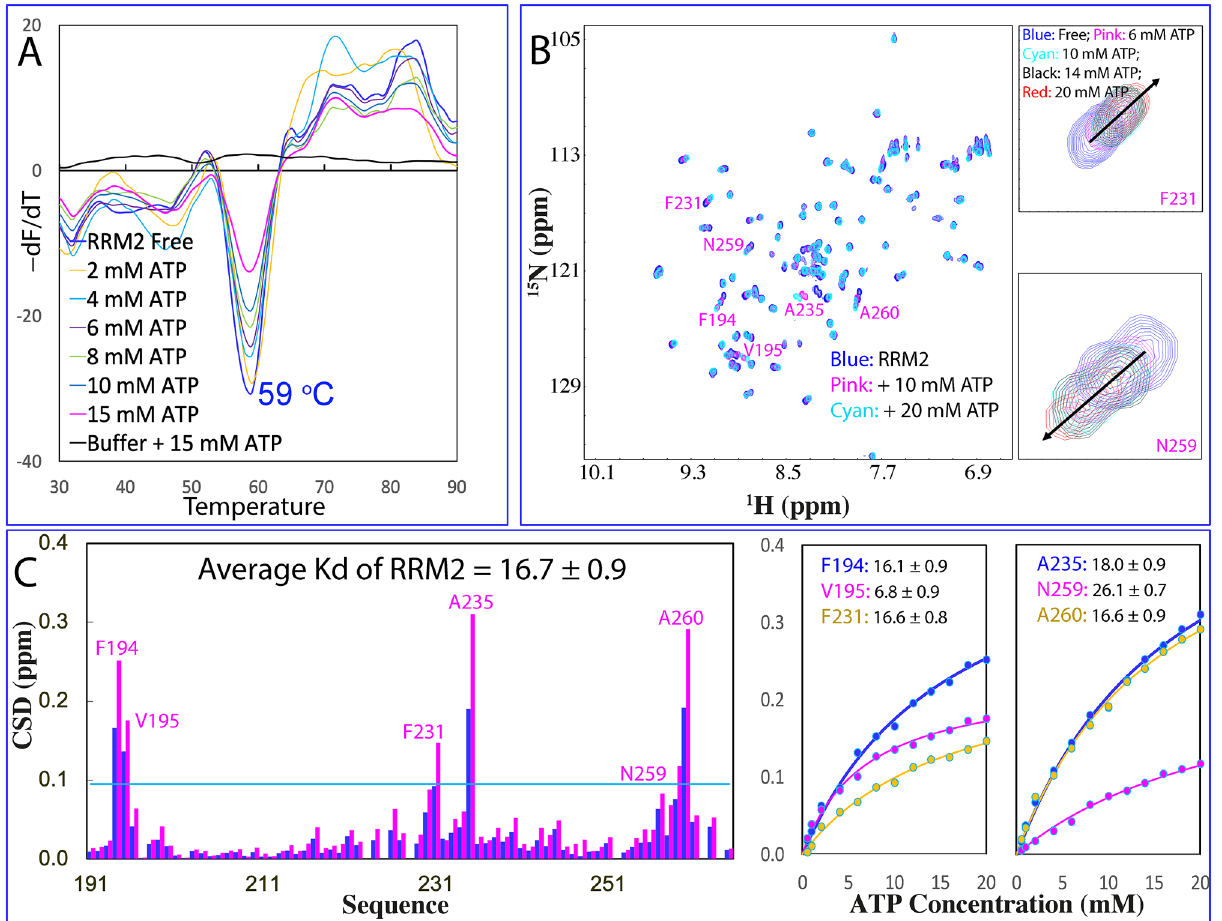
Figure 2. Thermal stability and ATP binding of the isolated TDP-43 RRM2. ( A ) DSF melting curves of thermal unfolding of the isolated RRM2 domain in the presence of ATP at different concentrations. ( B ) 1 H- 15 N NMR HSQC spectra of the 15 N-labeled RRM2 domain at 50 μM (blue) in 10 mM sodium phosphate buffer (pH 6.8) containing 150 mM NaCl and 10 mM DTT in the absence (blue), and in the presence of ATP at 10 (pink) and 20 (cyan) mM. Traces of two representative HSQC peaks, which have significant shifts but are not severely overlapped with other peaks. For clarity, only peaks at five ATP concentrations are shown: in the free state (blue); in the presence of ATP at 6 mM (pink); 10 mM (cyan); 14 mM (black); and 20 mM (red). ( C ) Residue- specific chemical shift difference (CSD) of the isolated RRM2 in the presence of ATP at 10 mM (blue) and 20 mM (pink). Significantly shifted residues are labeled, which are defined as those with the CSD values at 20 mM ATP > 0.1 (average value + one standard deviation) (cyan line). Fitting of the residue-specific dissociation constant (Kd): experimental (dots) and fitted (lines) values for the chemical shift differences induced by addition of ATP at 0.5, 1.0, 2.0, 4.0, 6.0, 8.0, 10.0, 12.0, 14.0, 16.0, 18.0 and 20.0